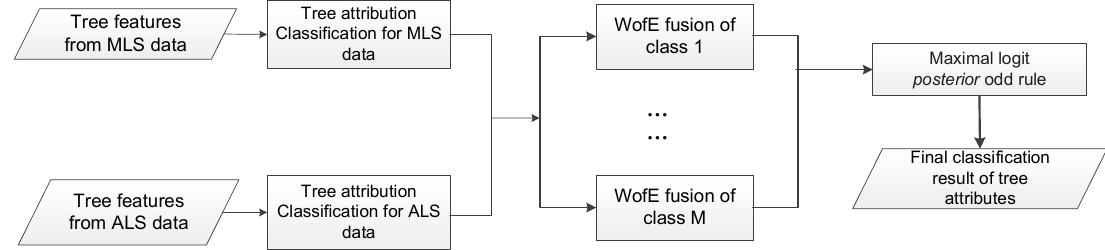
Figure 3. Workflow for single tree attributes classification based on weight-of-evidence (WofE) fusion.